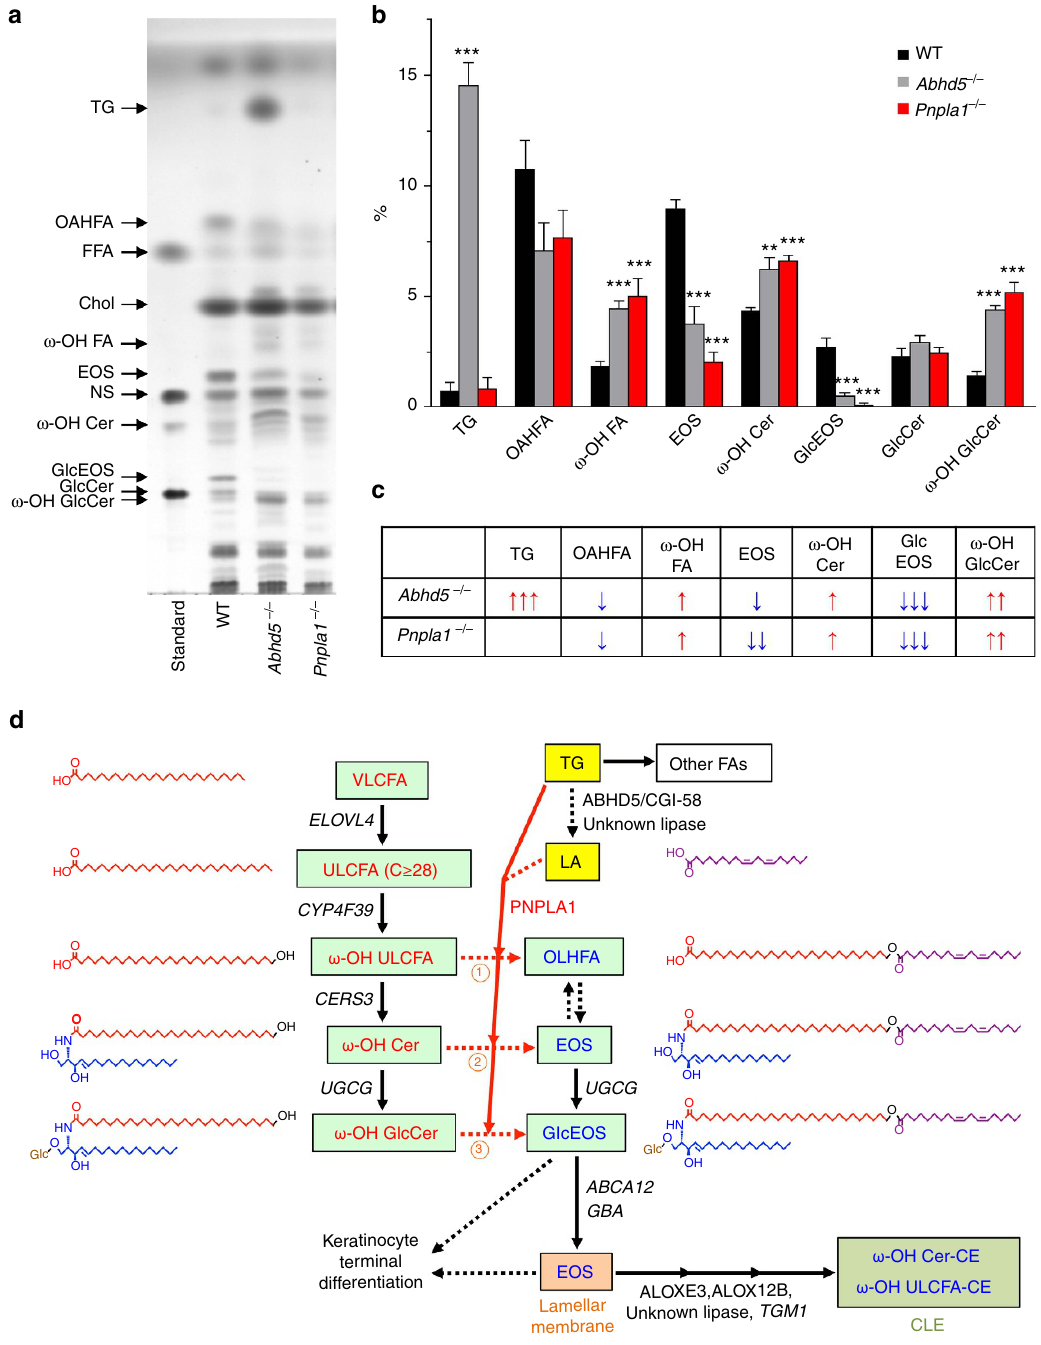
Figure 6 | Roles of PNPLA1 and ABHD5 in epidermal ceramide metabolism. ( a ) Representative TLC analysis of lipids extracted from WT, Abhd5 (cid:2) / (cid:2) , and Pnpla1 (cid:2) / (cid:2) epidermis at E18.5. ( b ) Quantification of panel A by densitometric analysis (mean ± s.e.m., n ¼ 6, 5 and 5 for WT, Abhd5 (cid:2) / (cid:2) and Pnpla1 (cid:2) / (cid:2) mice, respectively; ** P o 0.01 and *** P o 0.001 versus WTmice). Cumulative results of three independent experiments are shown. ( c ) A summary profile for a , b . Up and down arrows represent an increase and a decrease, respectively, in the level of individual lipids in mutant mice relative to WTmice. The number of arrows indicates the relative degree of difference. ( d ) Schematic diagram showing the proposed role of PNPLA1 in epidermal ceramide metabolism in association with keratinocyte differentiation and skin barrier function. Significantly increased and decreased lipid metabolites in Pnpla1 (cid:2) / (cid:2) epidermis are highlighted in red and blue, respectively. Upregulated enzymes are shown in italics. LA derived from TG appears to be esterified at the o -position of o -OH ULCFA, o -OH Cer and/or o -OH GlcCer (reactions 1, 2 and 3, respectively) by PNPLA1 transacylase. For details, see CoA-independent transacylase to form OAHFA, EOS and/or intercellular space of the SC. At the SC interstices, the GlcEOS. Glucosylation of ceramide occurs in the cis-Golgi glucosidase GBA deglycosylates GlcEOS to EOS, which form apparatus through the action of UDP-glucose ceramide lipid lamellae together with cholesterol and FFA. Two glucosyltransferase, UGCG, and then the resulting GlcEOS is lipoxygenases, ALOX12B and ALOXE3, sequentallly oxygenate incorporated into lamellar bodies and secreted into the the linoleate moiety in EOS (ref. 50), which then allows a second